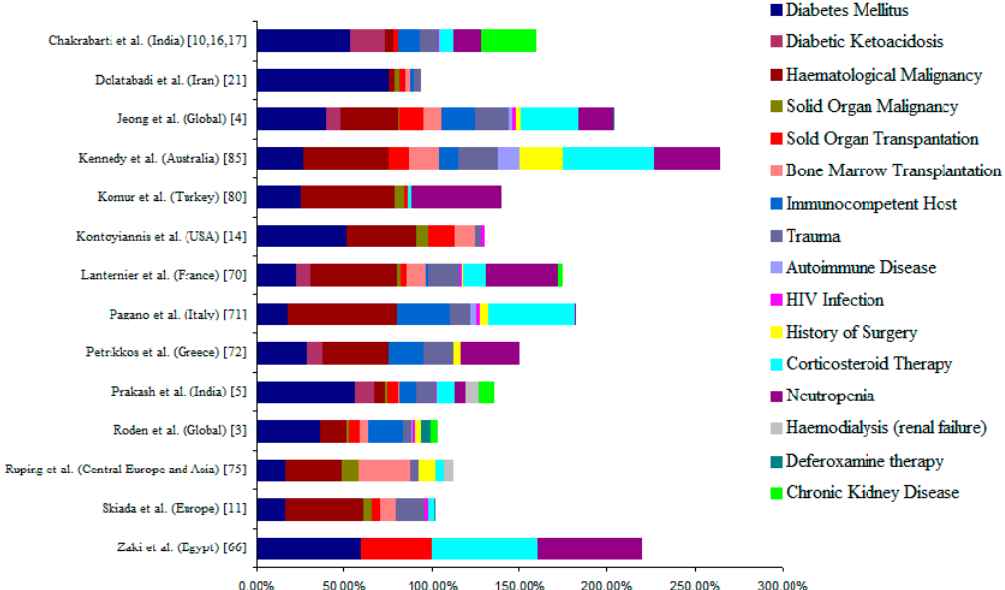
Figure 1. Underlying disease/risk factors associated with mucormycosis. The percentage of values given in the figure was calculated based on the data given in the literature. Percentage counts in total are more than actual values, because multiple risk factors are counted more than once. The data was pooled from studies by Chakrabarti et al. 2006, 2001, 2009 [10,16,17]. A contrasting difference in underlying disease/risk factors has been noted between the western world (USA and Europe) and the Asian region. Diabetes mellitus is the most common risk factor associated with mucormycosis in India [10,16,17], contrasting to haematological malignancy and transplant recipients in Europe and the United States [11,14]. Though a rise in the number of cases with haematological malignancies and transplantation as risk factors in India has been noted in recent years, huge number of cases with diabetes overshadows the picture [64].